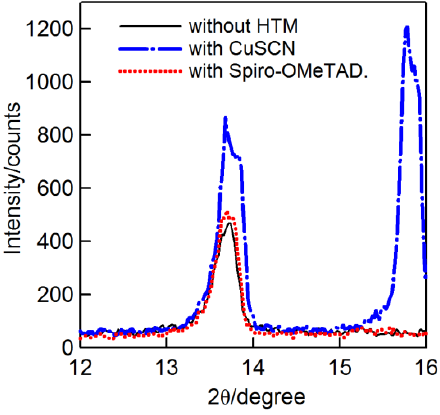
Figure 2. XRD patterns of one-step-processed CH 3 NH 3 PbI 3 perovskite layers varied by